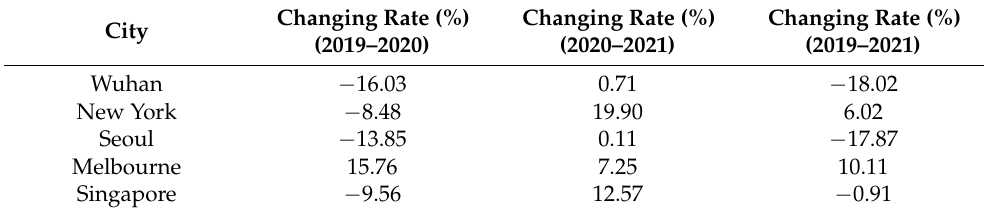
Table 3. Yearly (the first 26 weeks only) PM2.5 changing rate in five cities. City